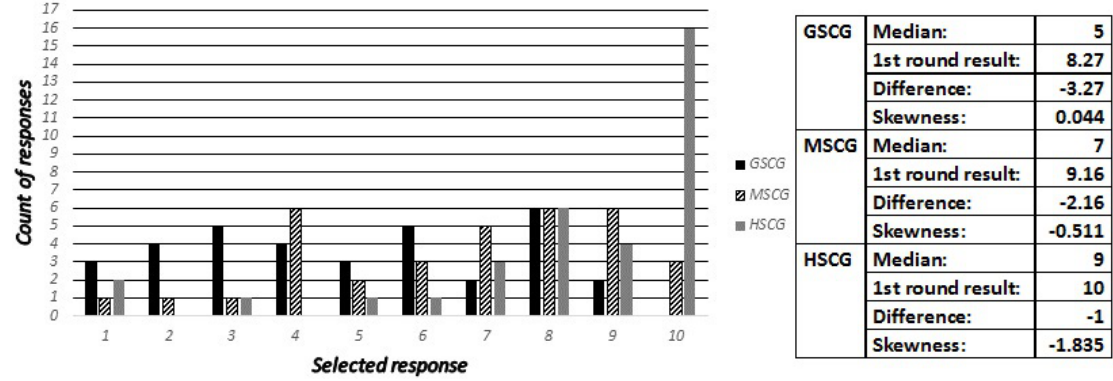
Figure 1. Results for question 1. Graph on the left shows distribution of expert predictions and the table to the right shows comparison